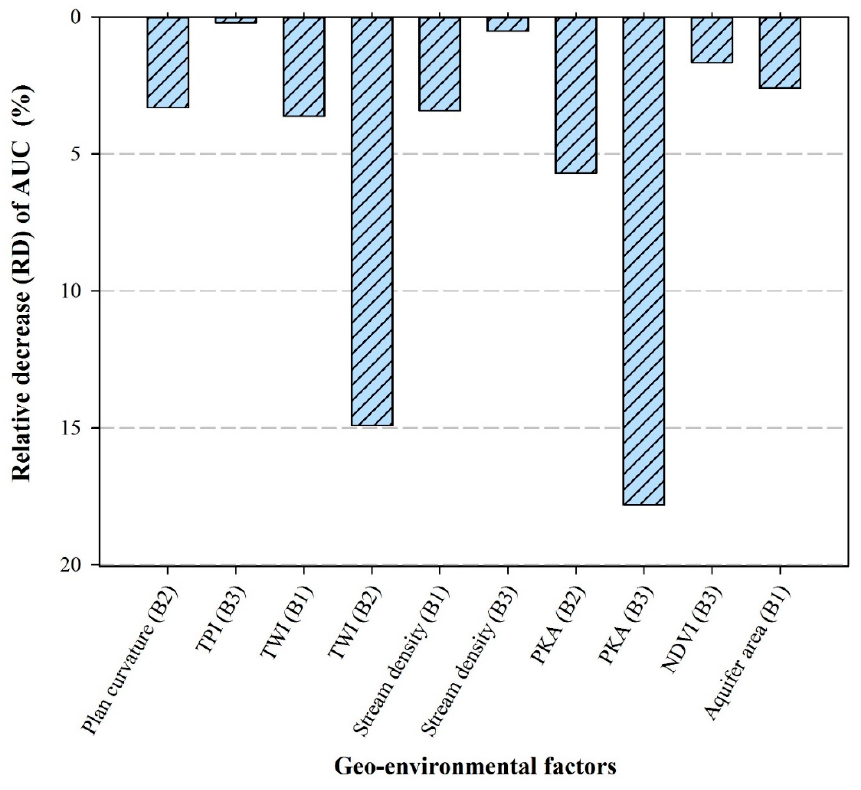
Figure 7. The relative decrease (RD) of AUC for each geo-environmental factor (B: buffer; TPI: topographical position index; TWI: topographic wetness index; PKA: percent of karstic area).